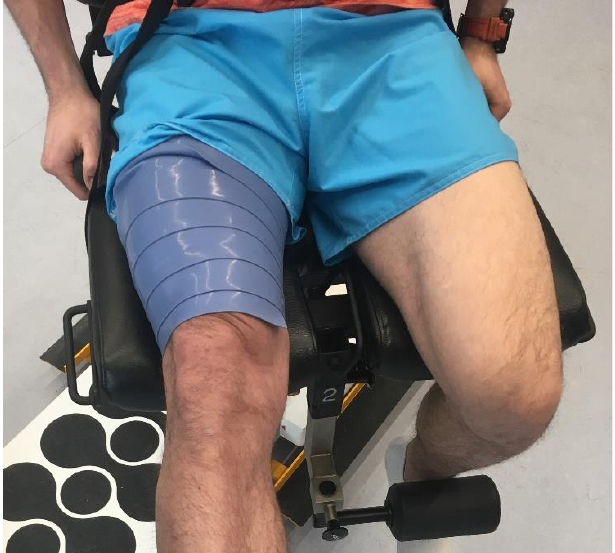
Figure 1. Application of a floss band on tight